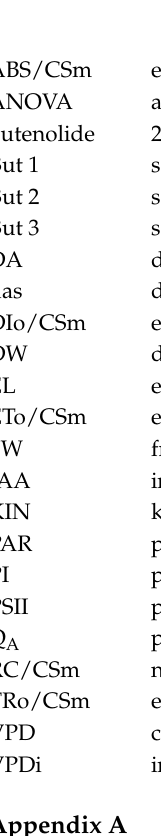
Table A1. Multiple reactions monitoring (MRM) transitions for the analysed phytohormones